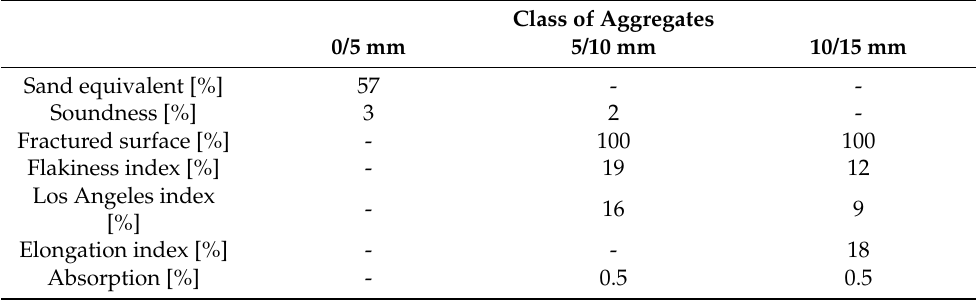
Table 1. Physical characteristics of